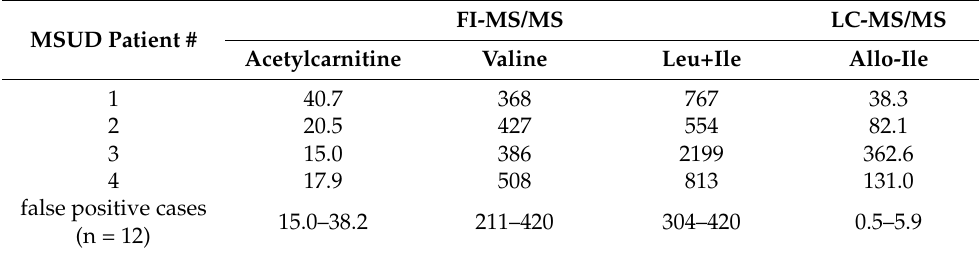
Figure 1. LC-MS/MS analysis of allo-Ile was performed using the following gradient elution program: 20% B (0.1 min), 20% to 30% B (3 min), 30% to 51% B (7 min), 51% to 100% B (0.1 min), 100% B (7.9 min), 100% to 20% B (0.1 min), and 20% B (5 min), with a flow rate of 0.3 mL/min. Table 2. Allo-Ile, related amino acid, and acetylcarnitine levels ( µ M) in patients with maple syrup urine disease, as measured by